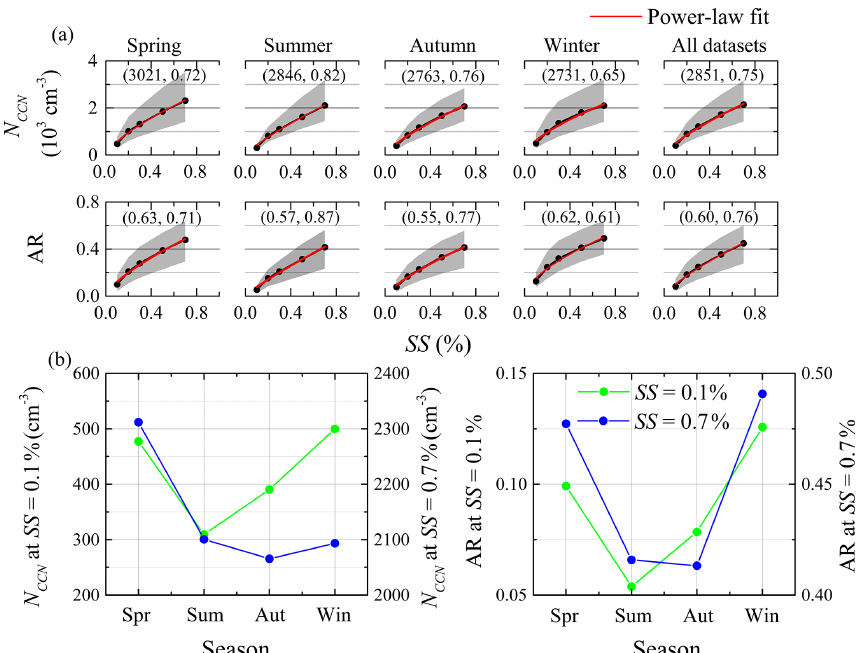
Figure 3. (a) Relationships between CCN number concentration ( N CCN ) and supersaturation (SS), and relationship between activation ratios (AR) and SS for different seasons. (b) Seasonal trends of N CCN and AR at SS = 0 . 1% and 0.7%. Dots represent the median values of N CCN and AR. Shaded areas represent the values in the range from the 25th to 75th percentile. Red lines are power-law fittings for N CCN (and AR) vs. SS. Two parameters of the fitting results are shown in